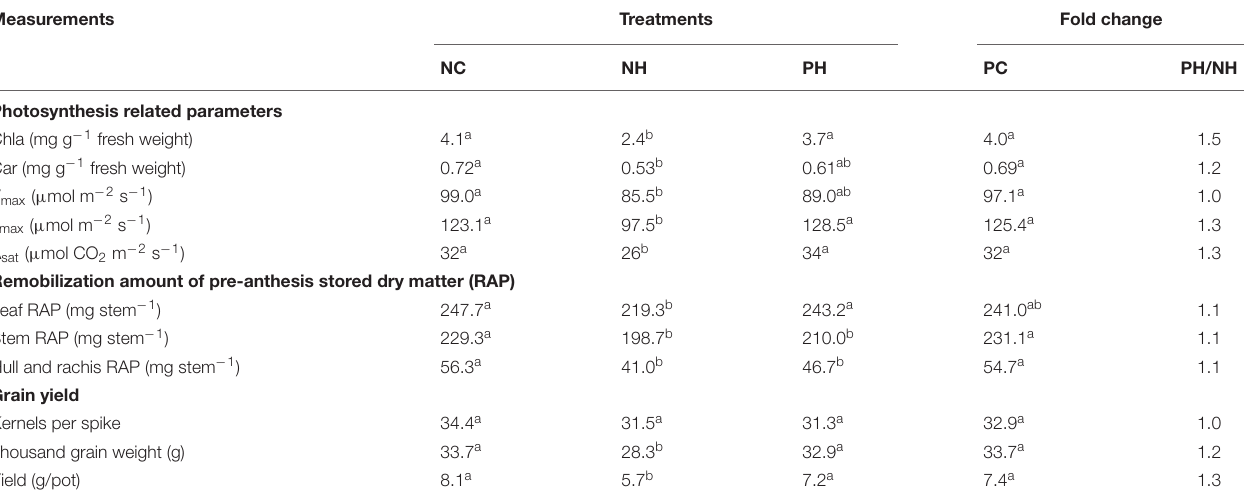
TABLE 1 | Progeny of heat primed plants showed better physiological performance than that of non-primed plants under high-temperature stress during grain filling. Measurements